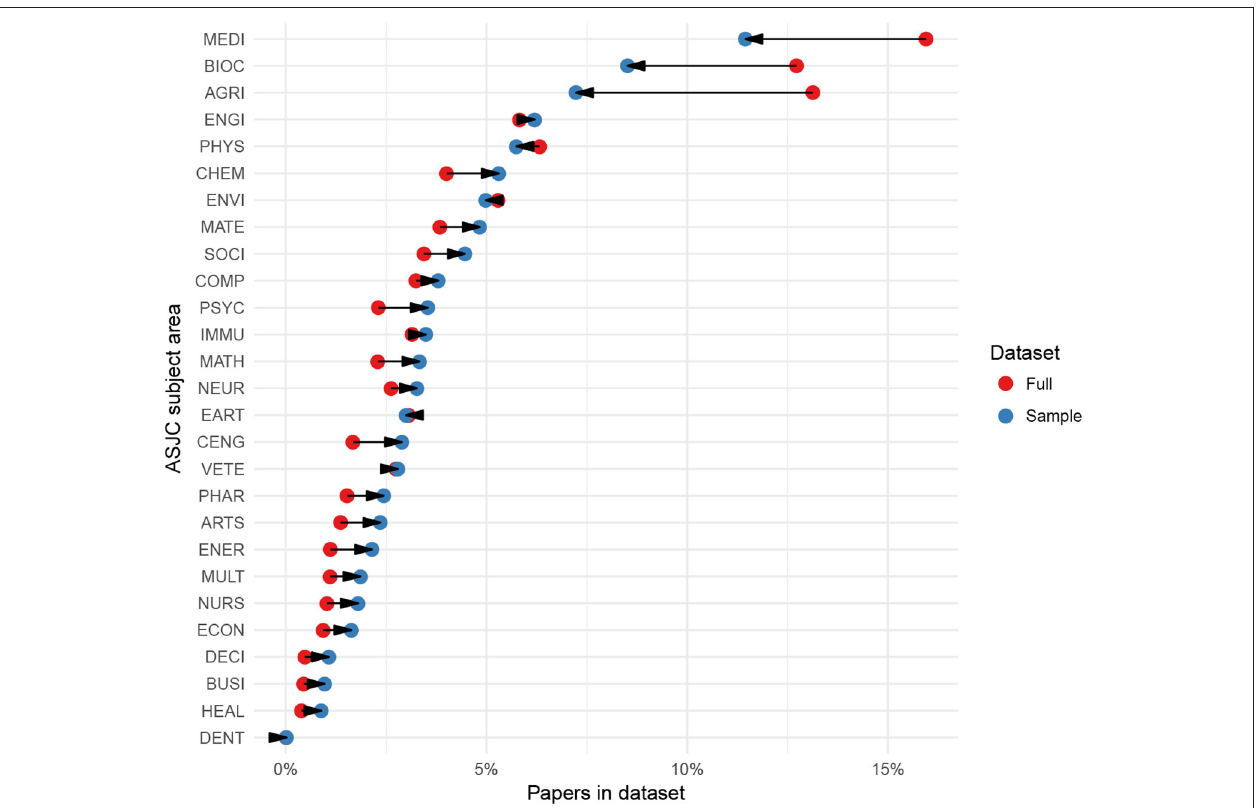
FIGURE 2 | Composition of full and sample datasets for textual analysis. The full dataset (6,344 papers; red points) is dominated by papers in fields such as medical research [MEDI], sub-organismal biology [BIOC], and agriculture [AGRI]. Drawing samples from each subject area separately decreased the fraction of papers from these fields, and modestly increased the fraction of papers from fields such as chemistry [CHEM] and psychology [PSYC] (2,354 papers; blue points). Because a given paper can be classified in more than one subject area, values do not necessarily add to